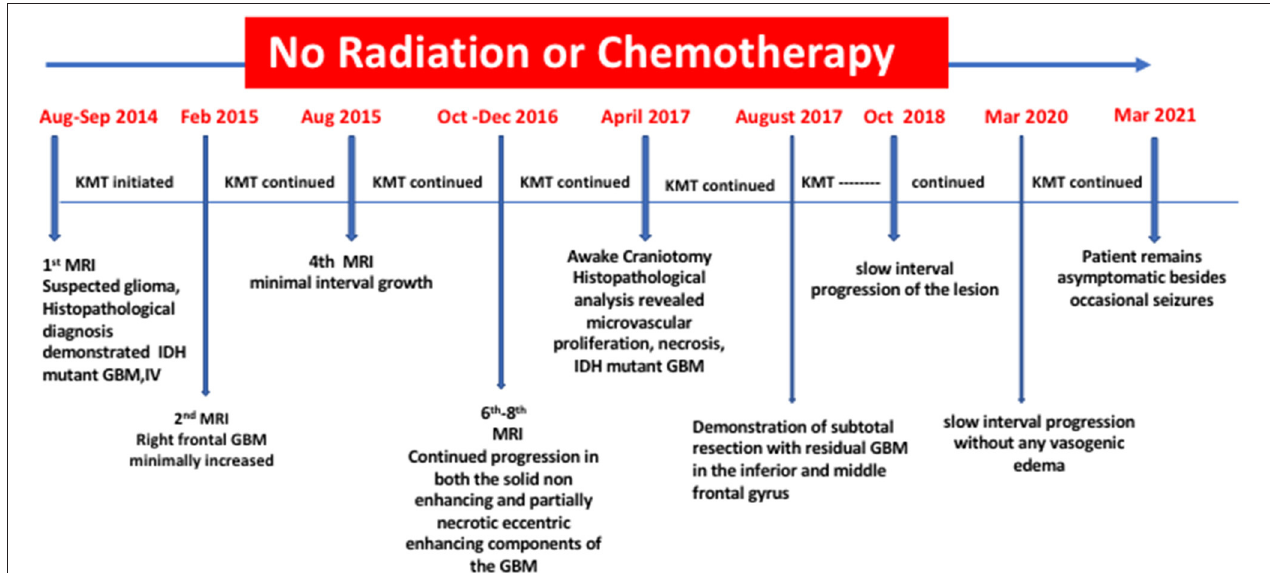
FIGURE 4 | Timeline of clinical course with dates of dietary treatments and MRI.